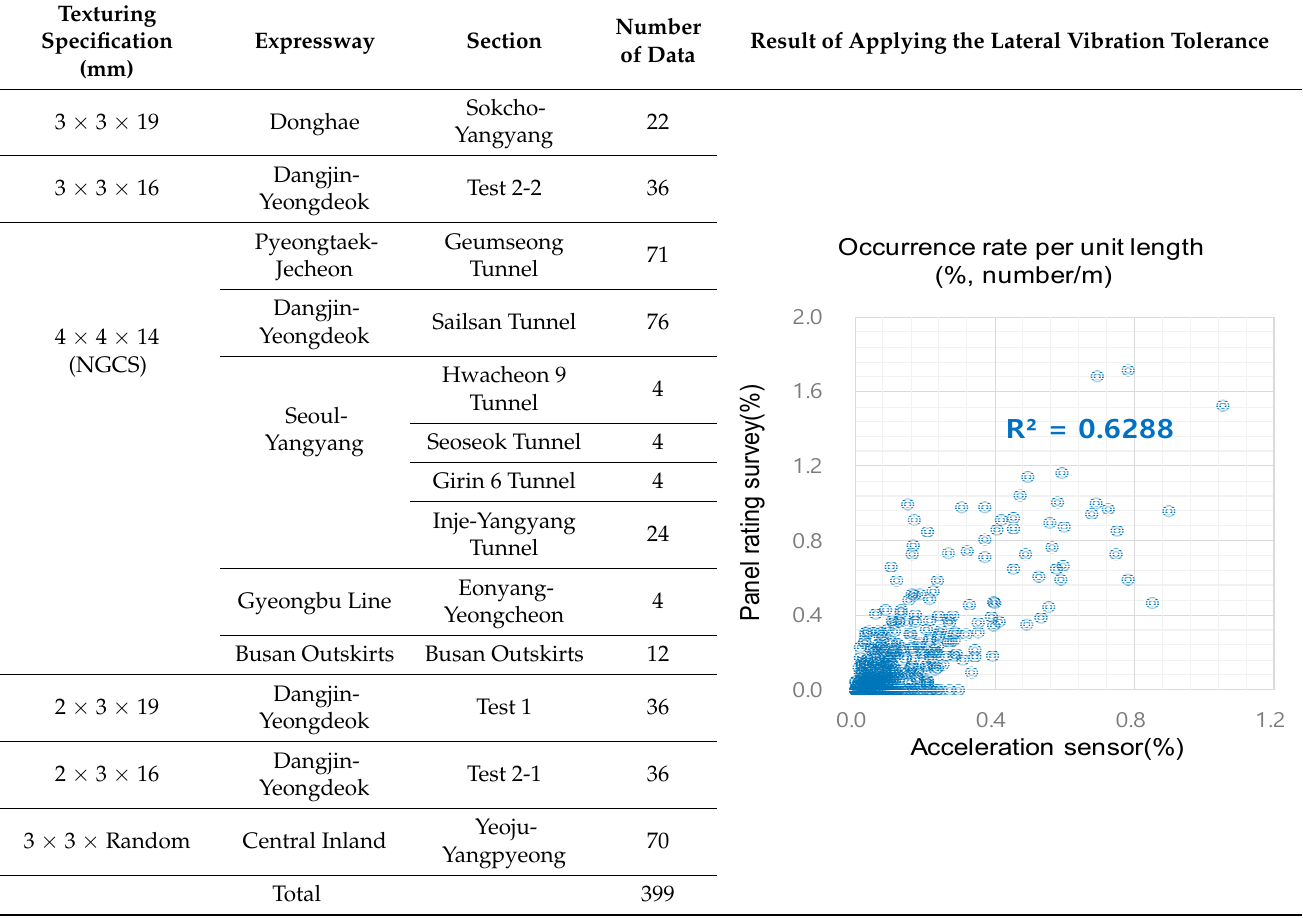
Table 3. Total field investigation sections and data statistics .